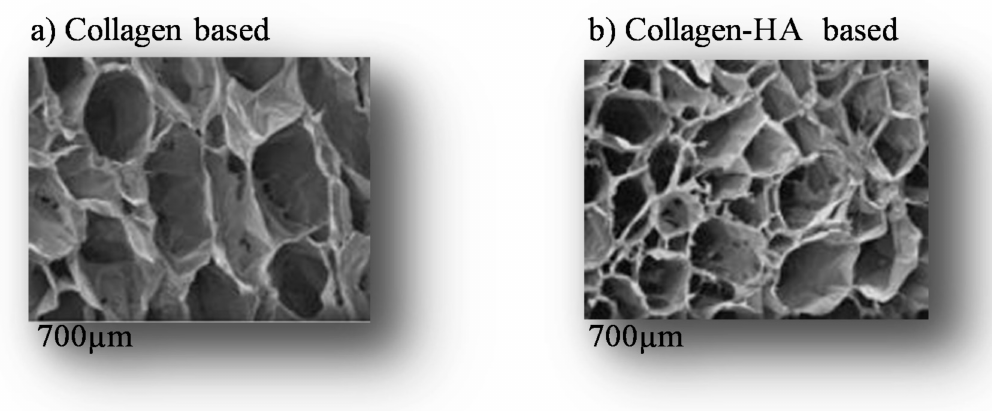
Figure 1. Scanning Electron Microscopy micrographs of the longitudinal sections of freeze-dried scaffolds of ( a ) collagen-based and ( b ) collagen-HA based (adapted from [219]). Polysaccharide-based hydrogels are natural hydrogels. Proteoglycans (PGs)